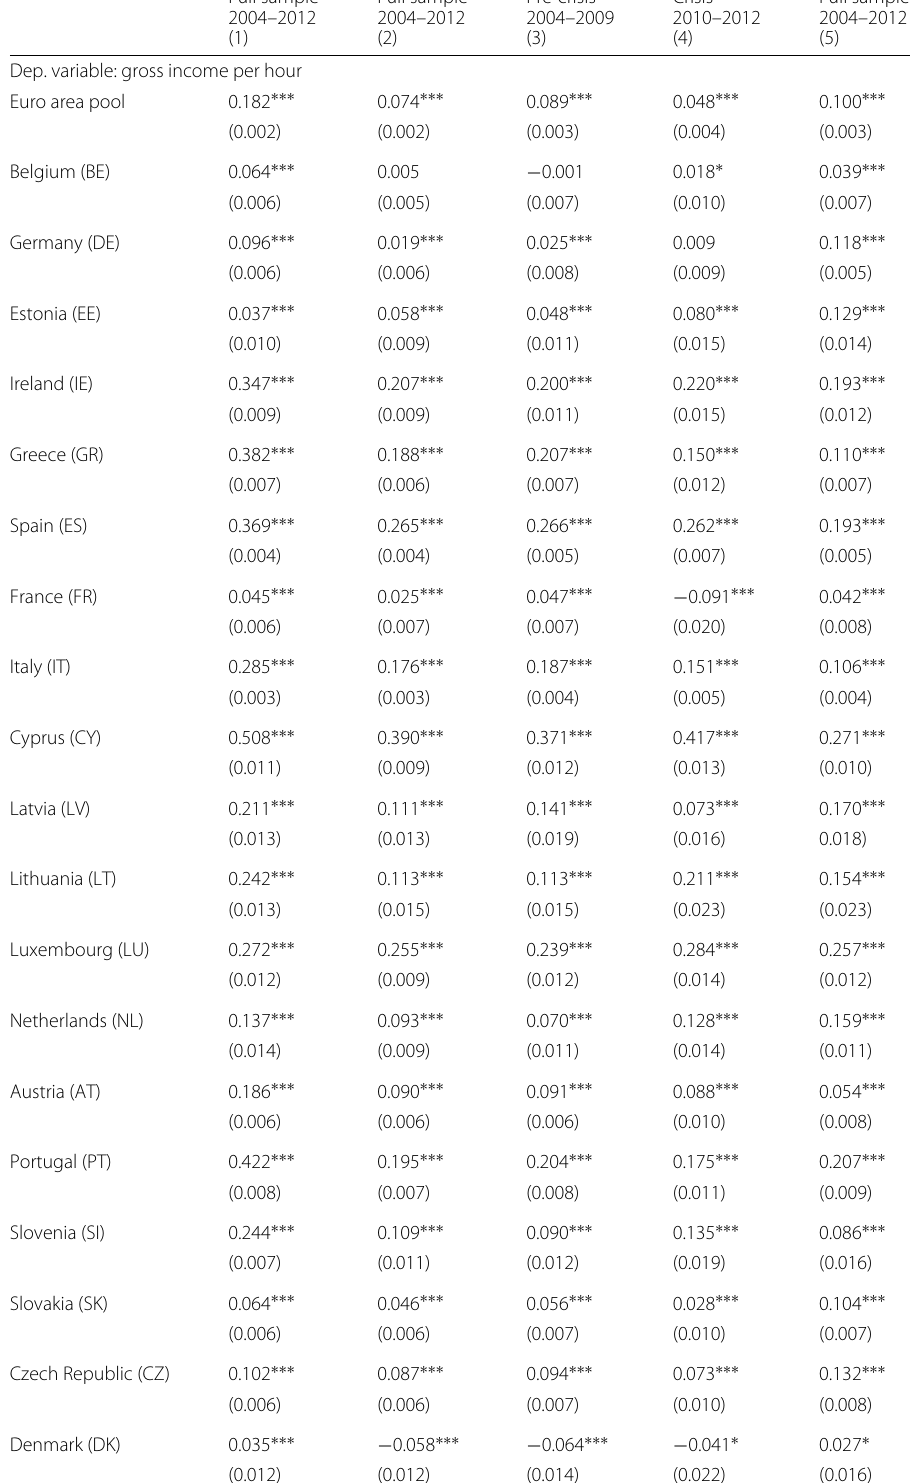
Table 1 Estimates of the public pay gap EU-SILC 25